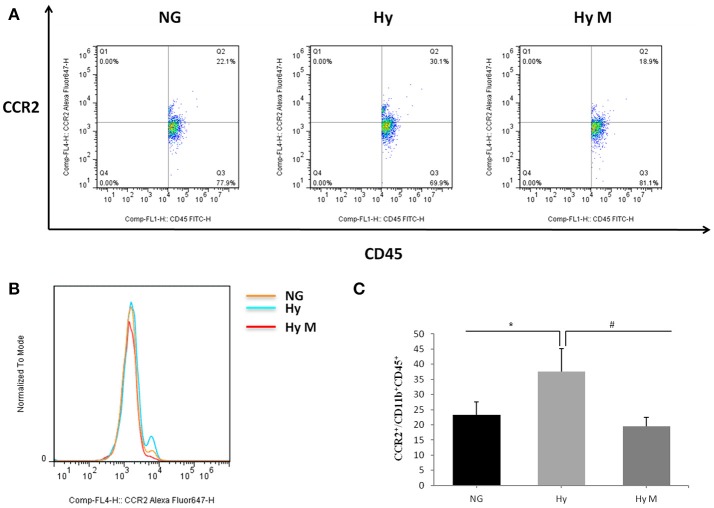
The percentage of CCR2+/CD11b+CD45+ after hypoxia. (A–C) Representative percentage (A) and histogram (B) of CCR2+ fluorescence intensity in CD11b+CD45+ cells after 3.5 h hypoxia and quantitation (c) of CCR2+/CD11b+CD45+ after hypoxia in indicated groups are illustrated. *p < 0.05 vs. NG group, #p < 0.05 vs. Hy group. n = 7 animals per group. Data expressed as means ± SEM. NG represents normal control rats; Hy represents hypoxia rats; Hy M represents hypoxia rats with minocycline treatment.